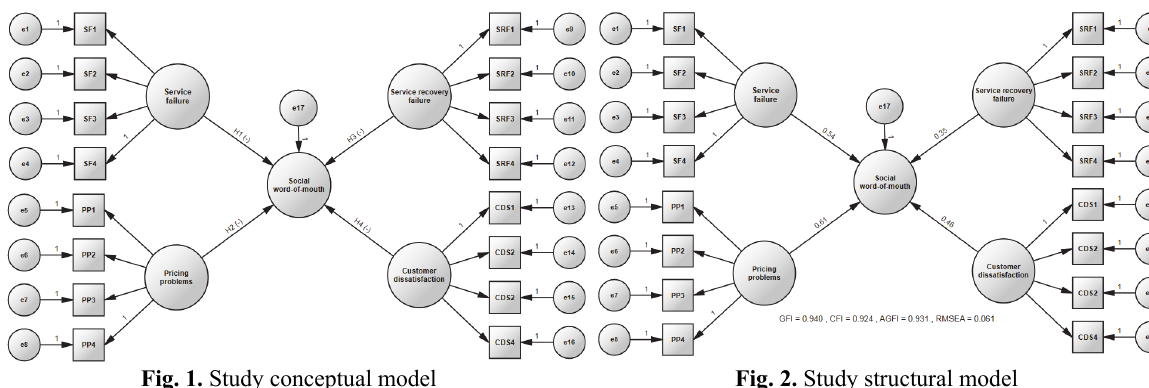
Fig. 1. Study conceptual model Fig. 2. Study structural model